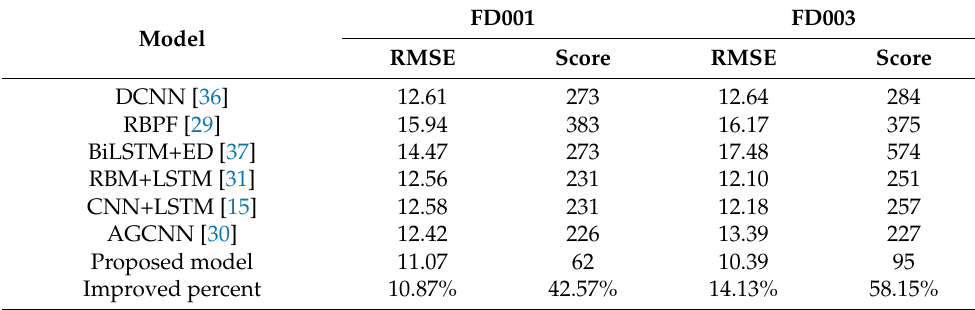
Table 7. Comparison of predicted results of different